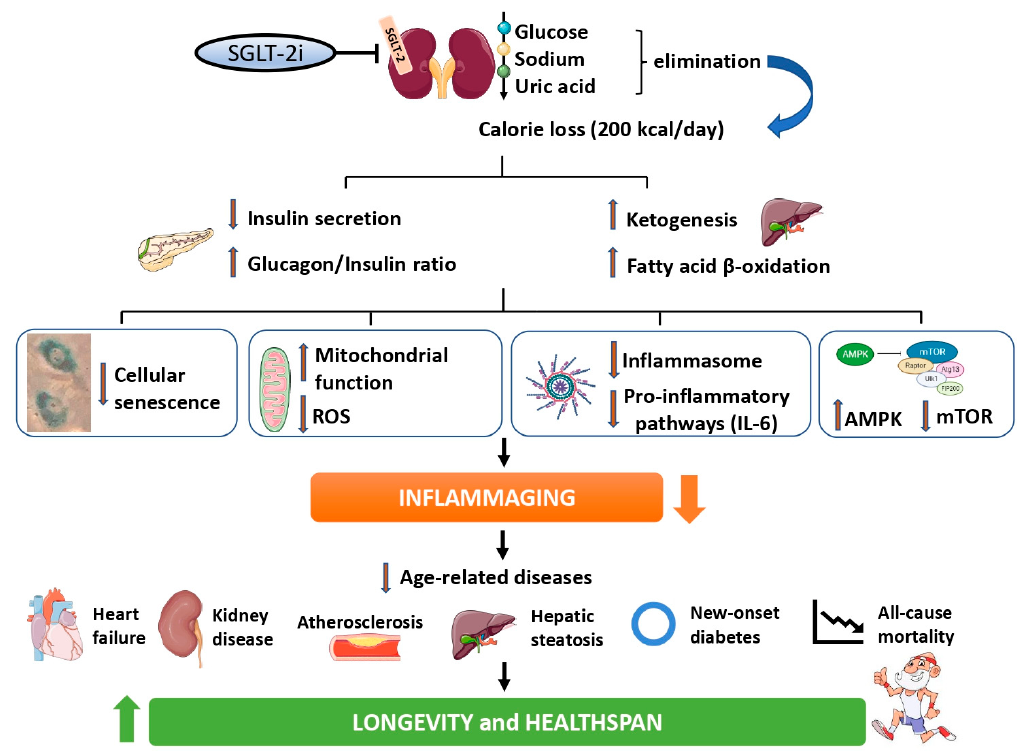
Figure 1. A graphical summary of the framework hypothesizing an anti-aging effect of SGLT-2i. SGLT-2i induce the elimination of glucose, promoting a loss of roughly 200 Kcal per day, a phenom- enon followed by a decrease in insulin levels and an increased glucagon/insulin ratio, which all together promote a shift from glycolysis towards fatty acids utilization and ketogenesis. This sys- temic metabolic and hormonal reshaping has been suggested to attenuate a range of pathways held to drive aging, including cellular senescence, the accumulation of ROS and mitochondrial dysfunc- tion, the activation of inflammatory pathways including the inflammasome platform, and the over- activity of key nutrient-sensing proteins such as mTOR. These effects might cumulatively amelio- rate inflammaging at the systemic level, and a lower degree of low-grade inflammation could ben- efit a large range of age-related outcomes, including cardiovascular diseases, kidney disease, diabe- tes development, hepatic steatosis, and all-cause mortality, ultimately promoting healthy longevity.